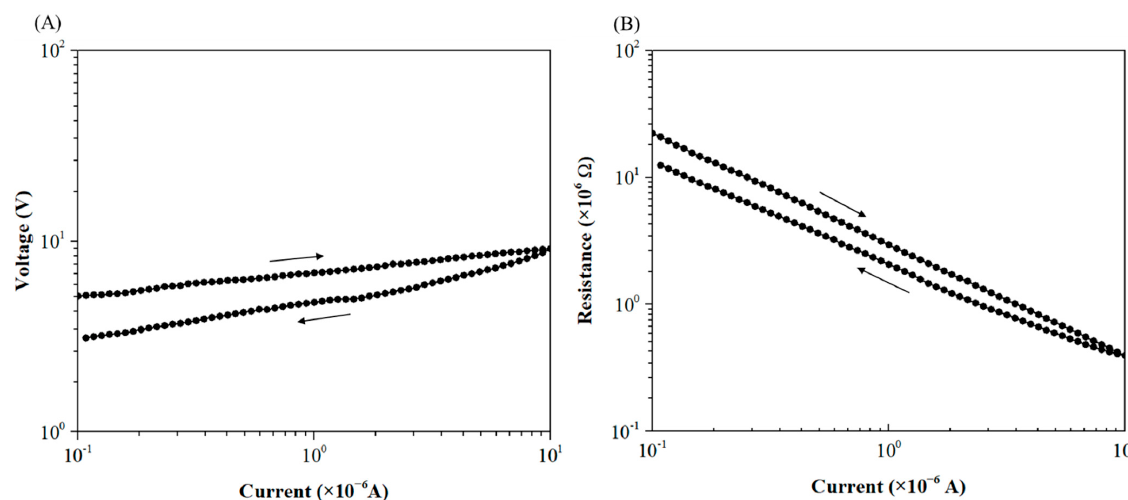
Figure 3. Typical U-I ( A ) and R-I ( B ) characteristics (logarithmic scale) for the raw powder at low Figure 3. Typical U - I ( A ) and R - I ( B ) characteristics (logarithmic scale) for the raw powder at low imposed current. imposed